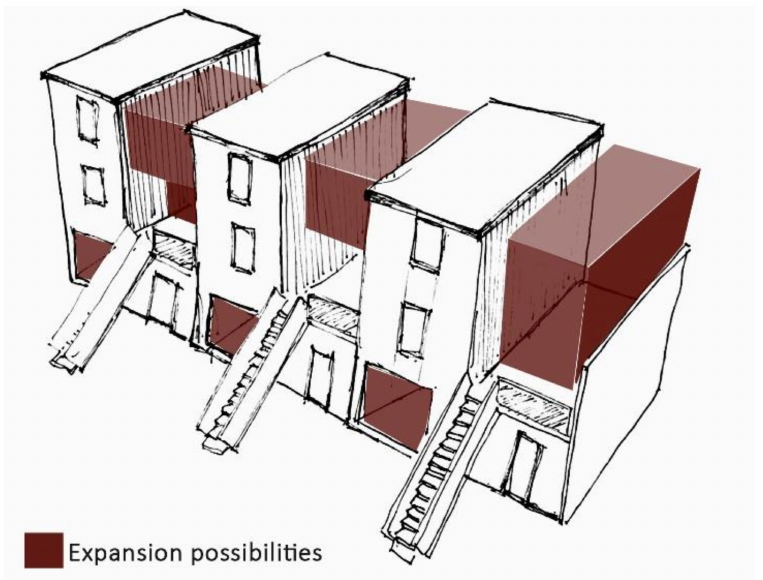
Figure 4. The incremental housing methodology in the Quinta Monroy project by architect Alejan- dro